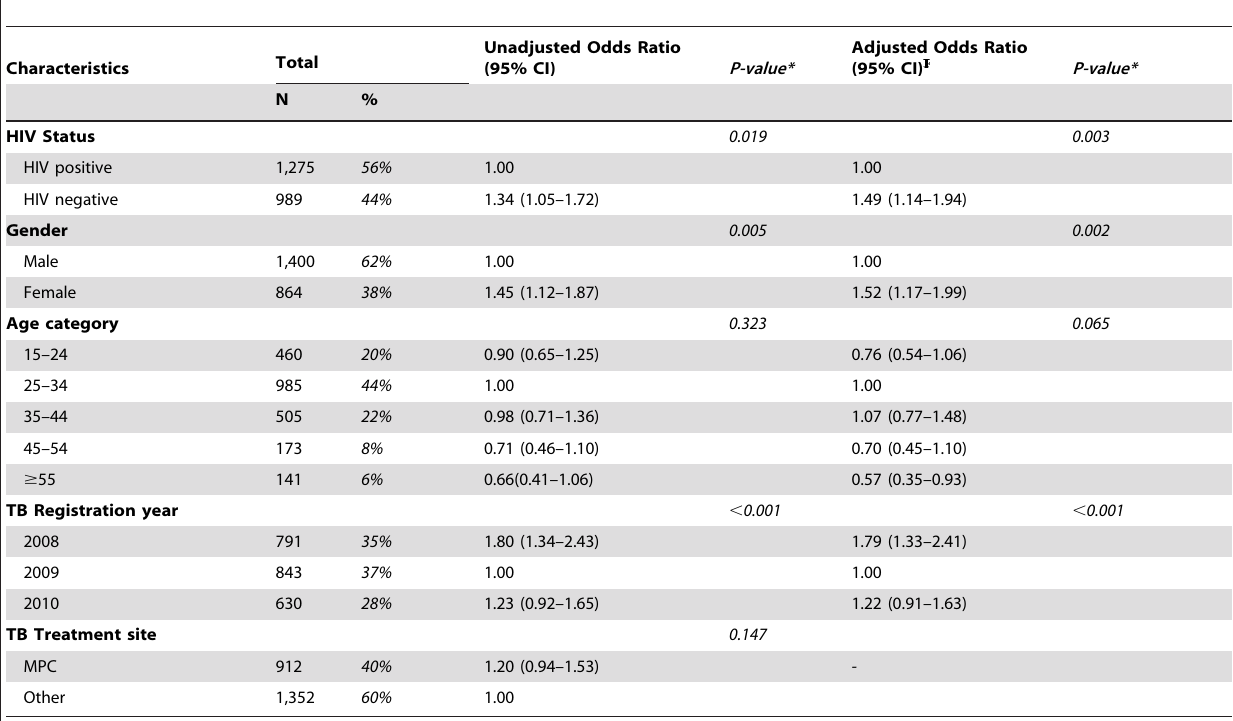
Table 3. Factors associated with TB treatment success among new smear-positive TB patients at Martin Preuss Centre between January 2008 and December 2010 (N =2,264) ¥